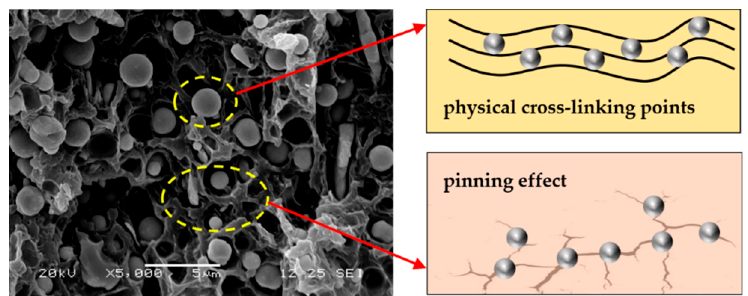
Figure 6. The SEM image of sample C-40 and a hypothetical microscopic mechanism of CIPs on the enhanced mechanical properties.